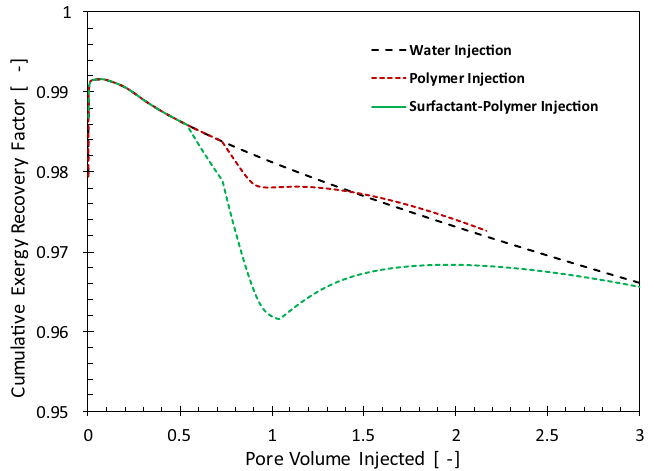
Figure 12. History of cumulative exergy recovery factor for water-, polymer- and surfactant/polymer-injection